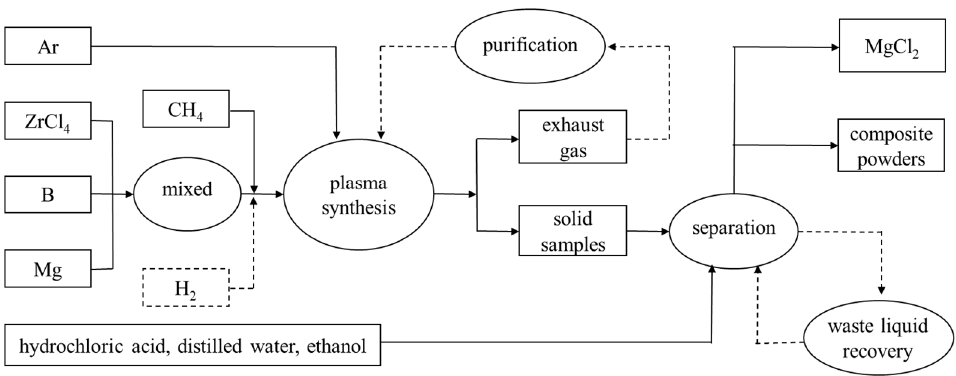
Figure 2. Process flow chart for plasma synthesis of ultrafine ZrB 2 -ZrC composite powders.